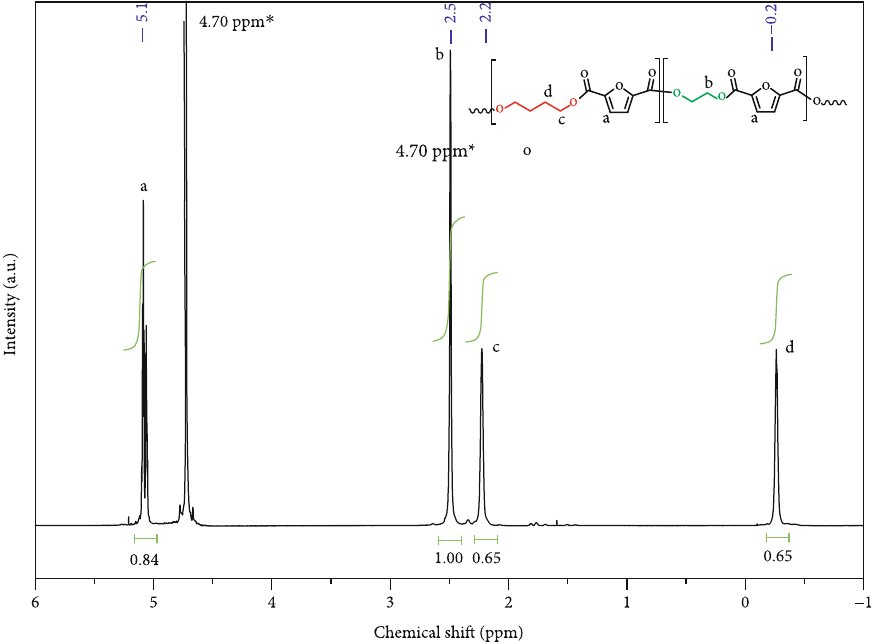
Figure 3: 1 H NMR spectrum of a copolymer synthesized with feed ratio of MEG : BD = 5 : 5 (internal standard D tagged “ ∗ ” at